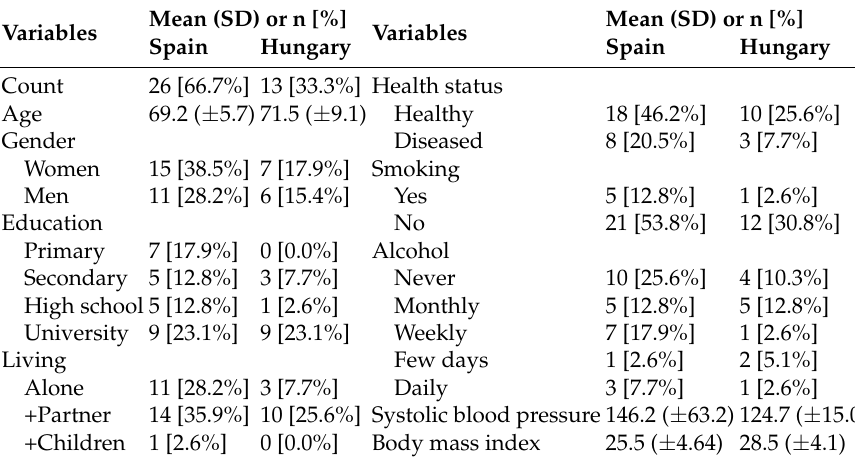
Table 4. Characteristics of Study